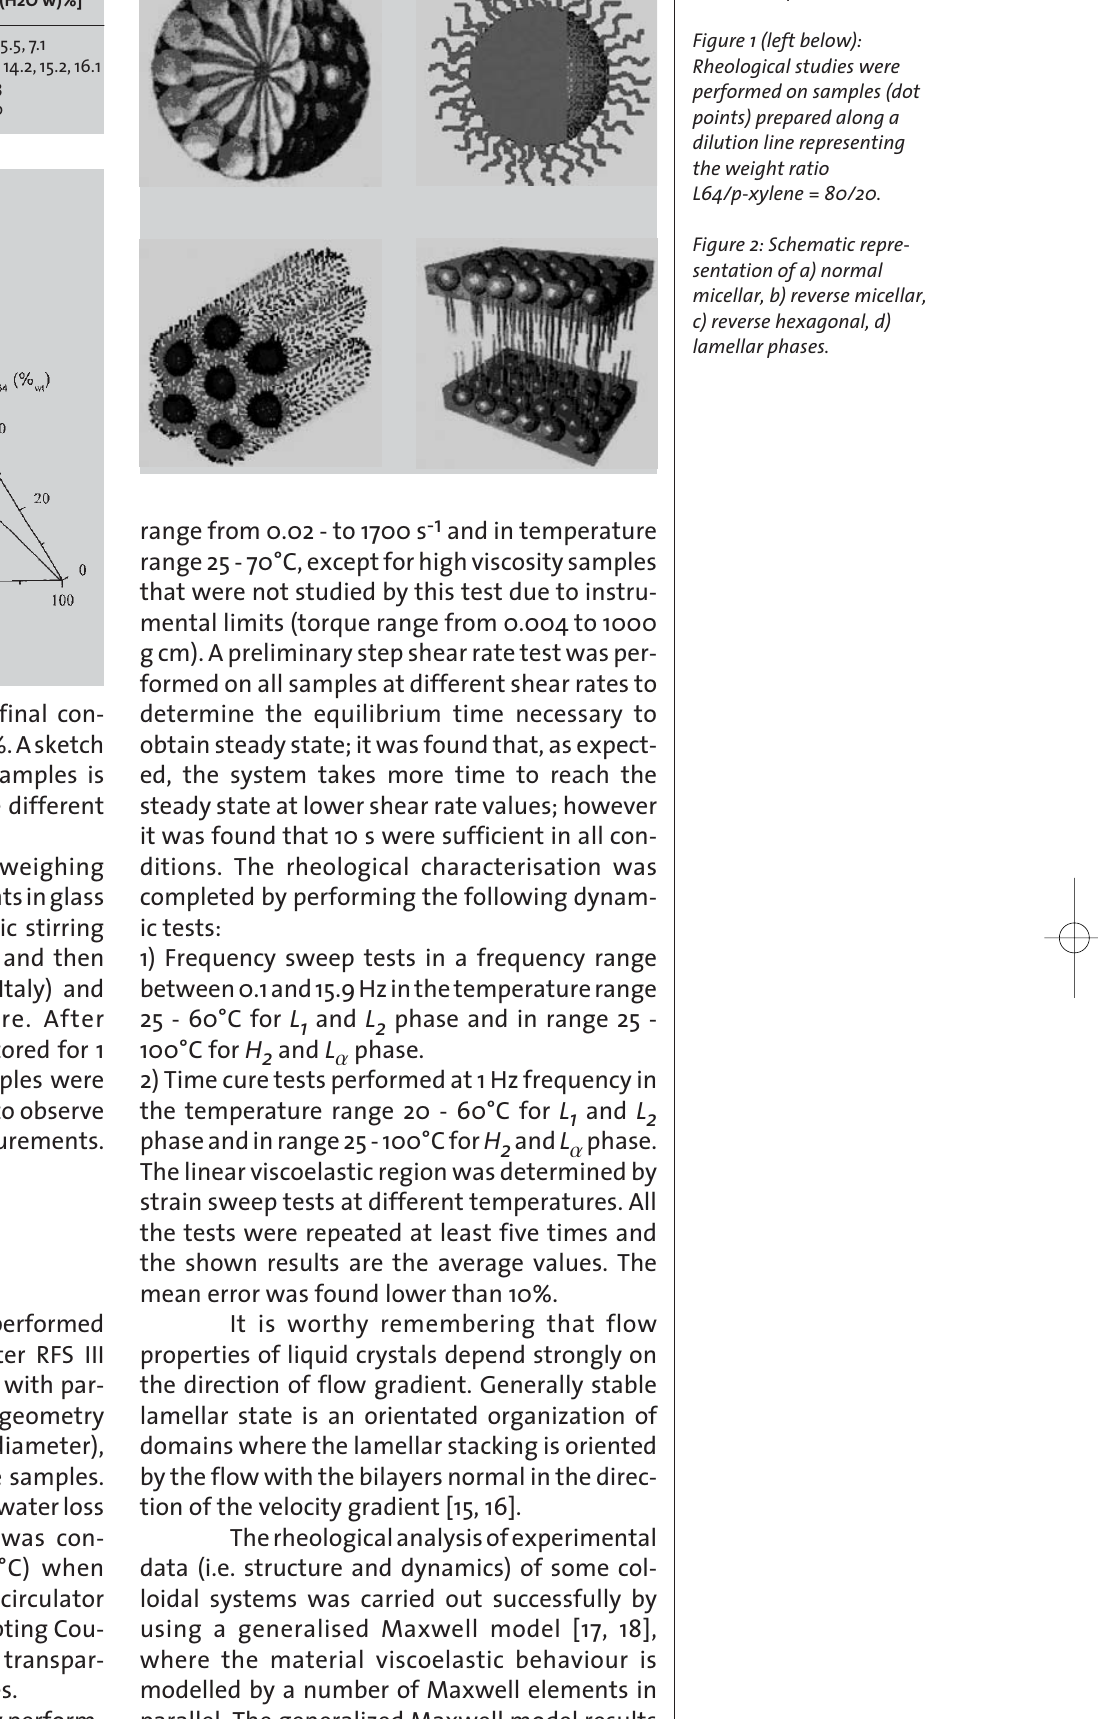
Table 1 (left above): Tested sample. Figure 1 (left below): Rheological studies were performed on samples (dot points) prepared along a dilution line representing the weight ratio L64/p-xylene = 80/20. Figure 2: Schematic repre- sentation of a) normal micellar, b) reverse micellar, c) reverse hexagonal, d) lamellar